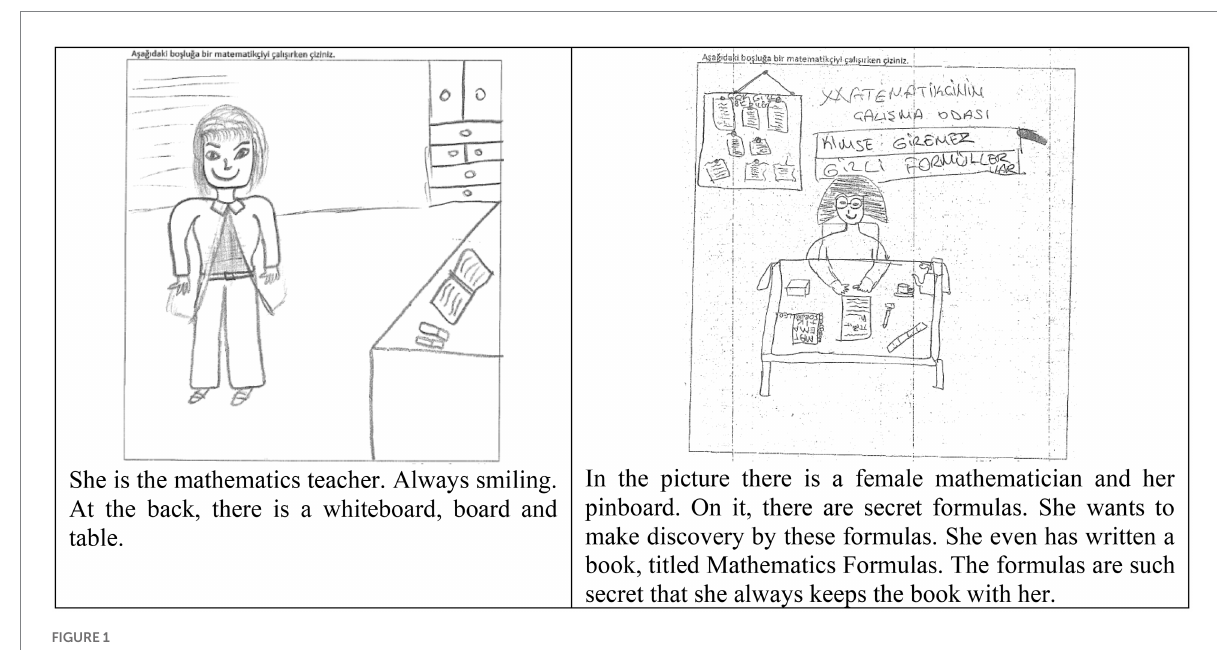
FIGURE 1 Examples of draw-a-mathematician-test (DAMT) research drawings (Hatisaru and Murphy,